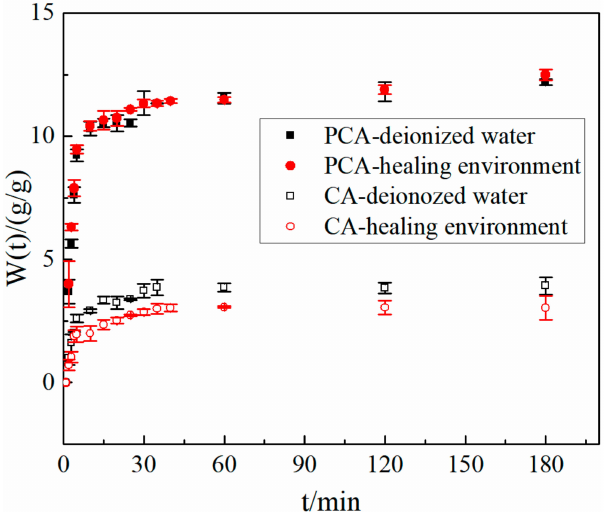
Figure 7. The swelling rate of two kinds of ca-alginate beads in cement filtrate over